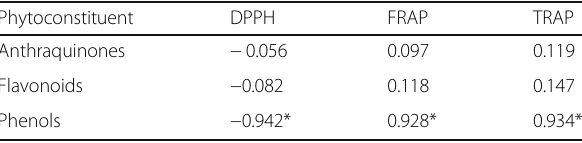
Table 3 Pearson ’ s correlation coefficient (r) for phytochemicals and antioxidant